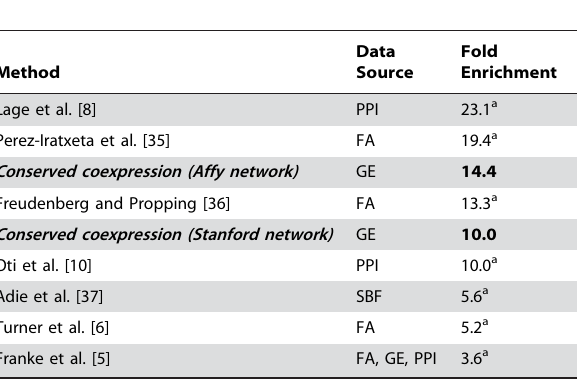
Table 1. Fold enrichment of different methods for candidate gene